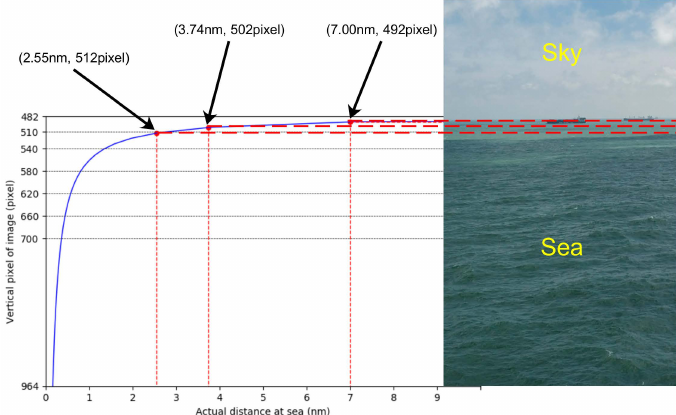
Figure 6. Relationship between the pixel points on the image and the actual distance at